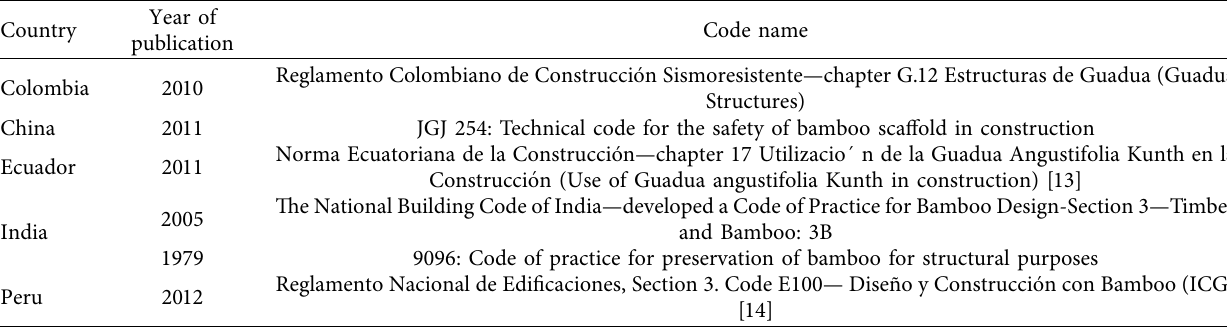
Table 1: Codes for bamboo structural design.